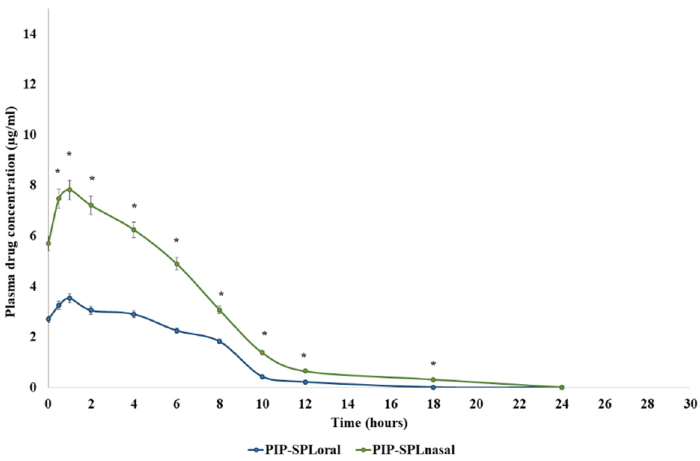
Figure 8. Plasma drug concentration profiles of piperine after oral and intranasal delivery. *: statis- tically significant at p ≤ 0.01.